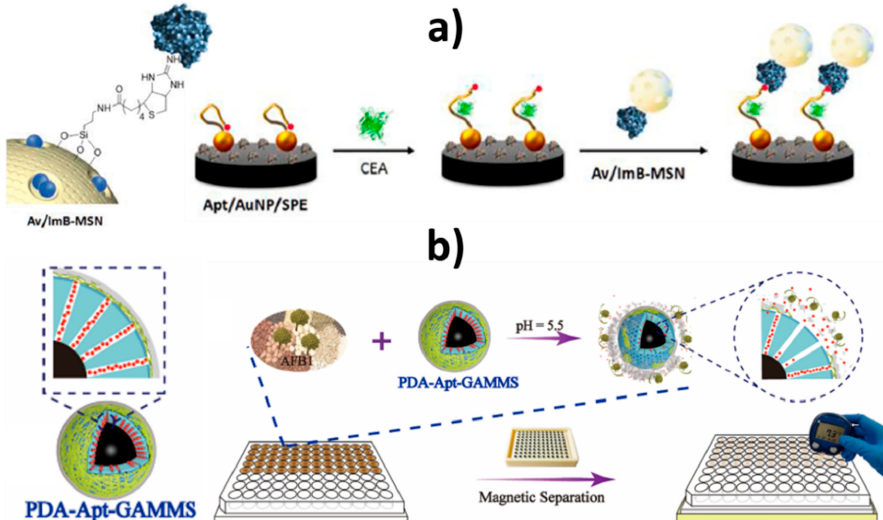
Figure 11. Schematic display of the aptasensing strategy reported for the amperometric determination of CEA involving the use of aptamer and HRP bifunctionalized Au-MS JNPs, Av-Fe 3 O 4 @SiO 2 NPs and amperometric detection at SPCEs. Reprinted and adapted from [183] with permission. amperometric detection at SPCEs. Reprinted and adapted from [183] with